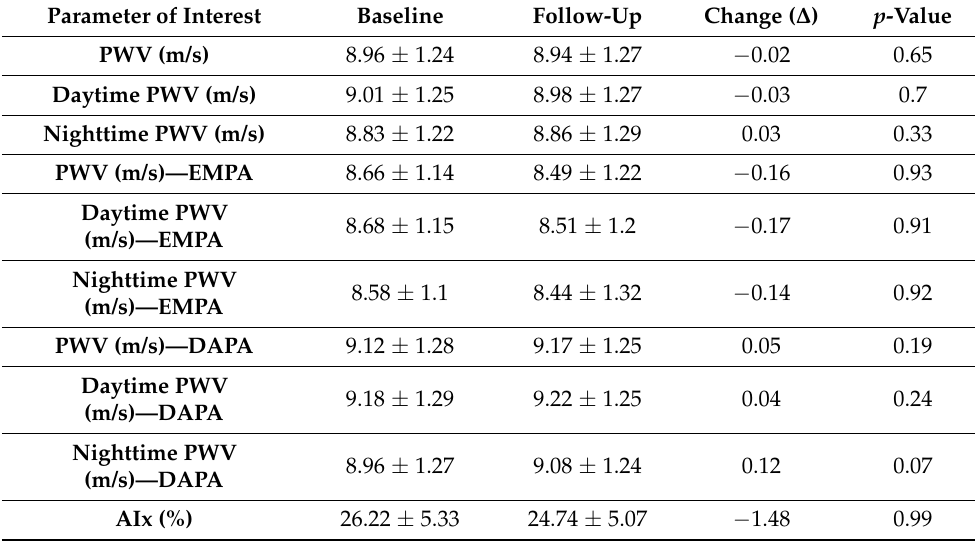
Table 1. Effect of SGLT-2 inhibitors on major prespecified